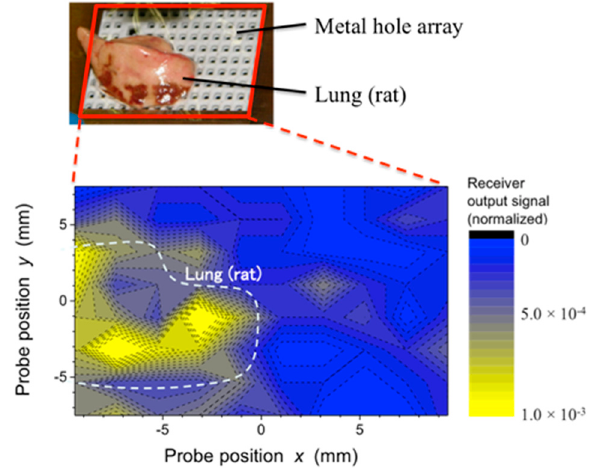
Figure 18. The result of biomedical diagnosis by using an MHA with rectangular holes (the size is 1.8 mm × 1.4 mm, the periods of each direction are 2.5 mm, 2 mm and the thickness is 2.3 mm) in the case of a rat lung.